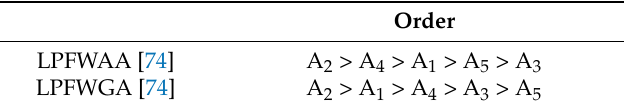
Table 10. Order of the green